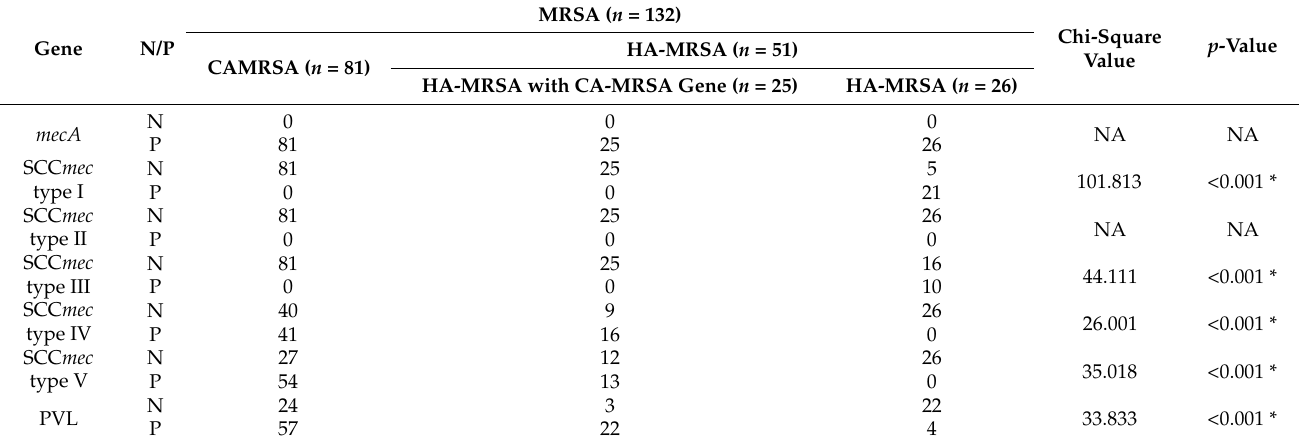
Table 3. Prevalence of the SCC mec and PVL genes among the MRSA